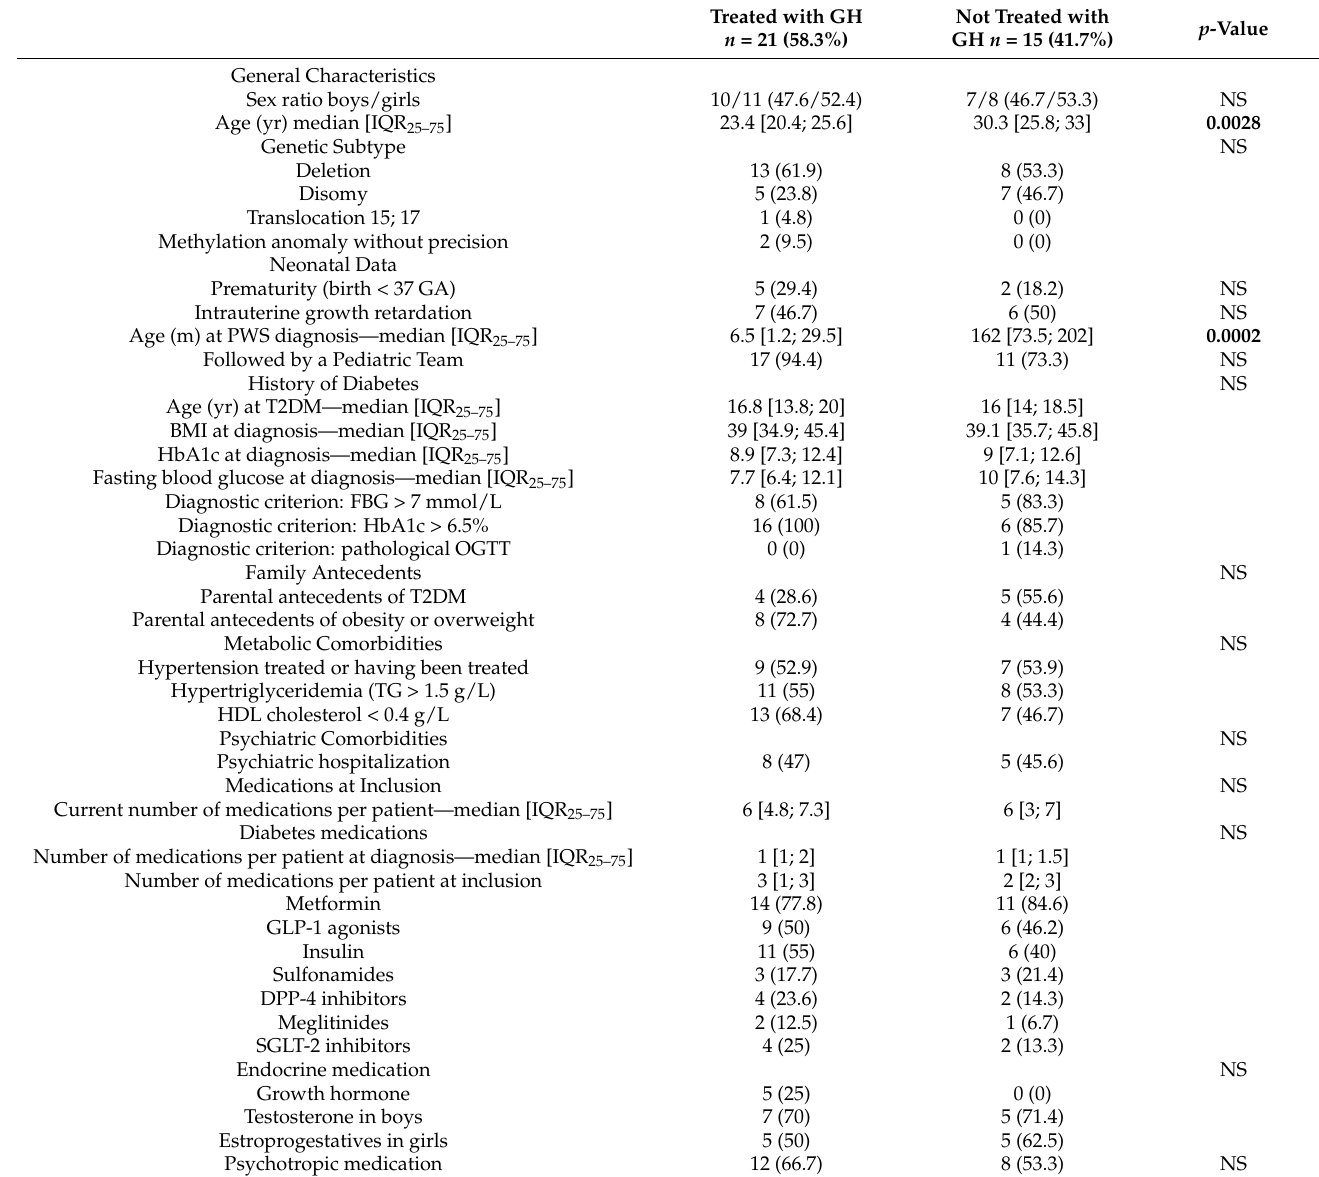
Table 3. Comparison of patients previously treated with GH with those never treated ( n = 36).